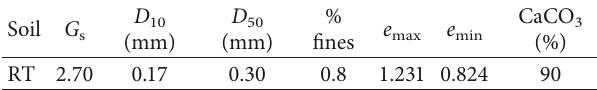
Figure 8: Initial and final positions of the SDG during a com- pression test. Table 4: Physical properties of Rottnest sand. Soil G s